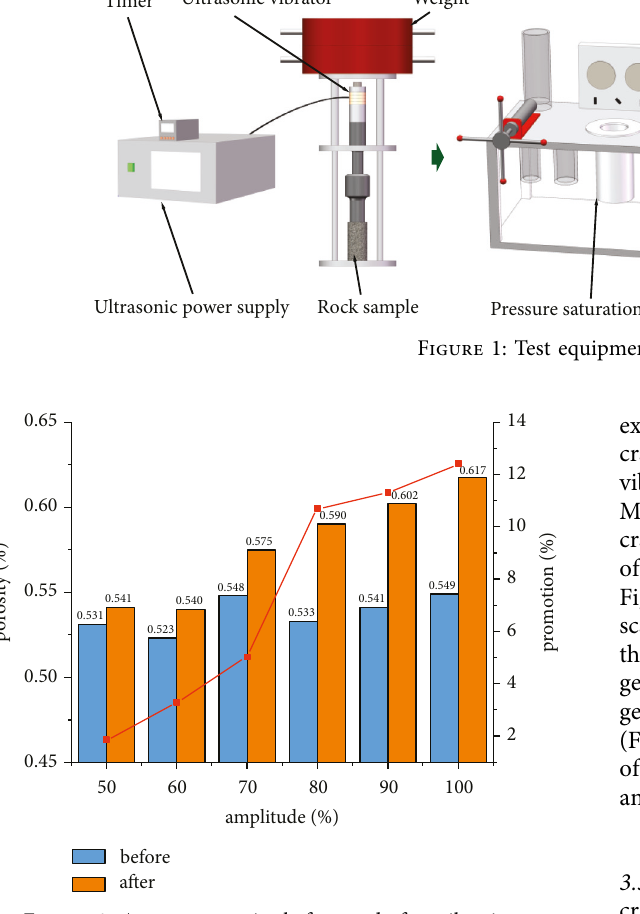
Figure 2: Average porosity before and after